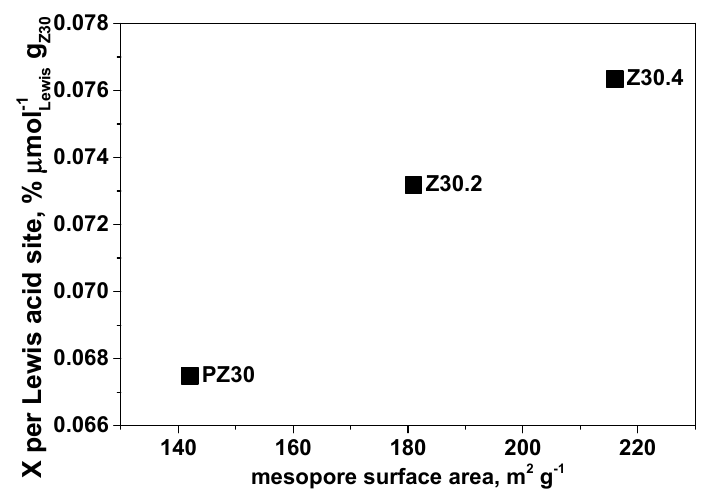
Figure 11. Conversion per Lewis acid site for untreated and treated Z30 vs mesopore surface area for cycloaddition reaction of DMF with ethylene. Reaction conditions: 180 °C, 40 bar total pressure (pressurised at 180 °C), 5.5 mL DMF, 0.45 mL tridecane (internal standard), 16.5 mL hexane, 110 mg catalyst, 20